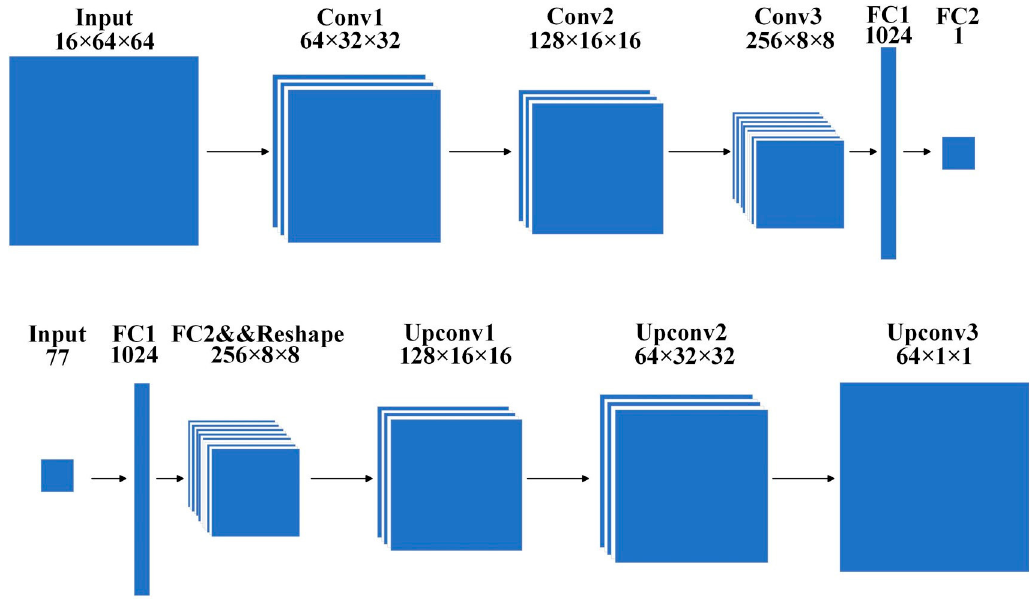
Figure 8. CGAN network structure proposed by Liu et